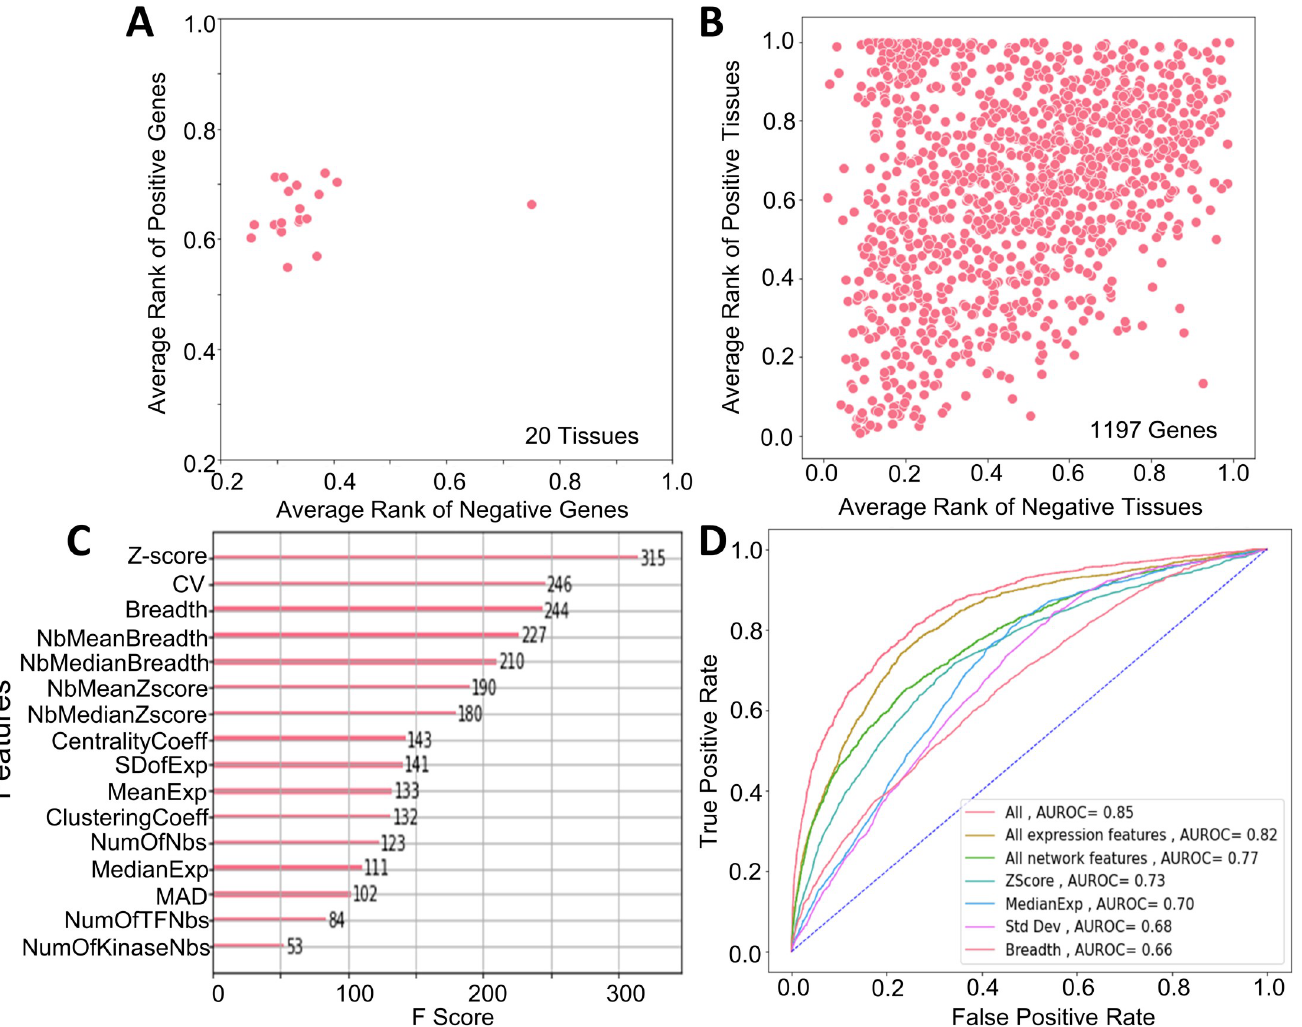
Fig 2. FUGUE performance. (A) Positive genes in each tissue is ranked based on a model trained on other tissues. Mean rank of positive genes in each tissue (y-axis) is consistently far higher than the negative genes in that tissue. (x-axis). (B) Similar to (A) but here each gene’s rank in Positive tissue (y-axis) is compared with the same gene’s rank in negative tissues (x-axis); the model training excludes the gene of interest. (C) Each feature’s importance (F score) estimated by the model is shown. (D) ROC for overall cross-validation accuracy for various combinations of